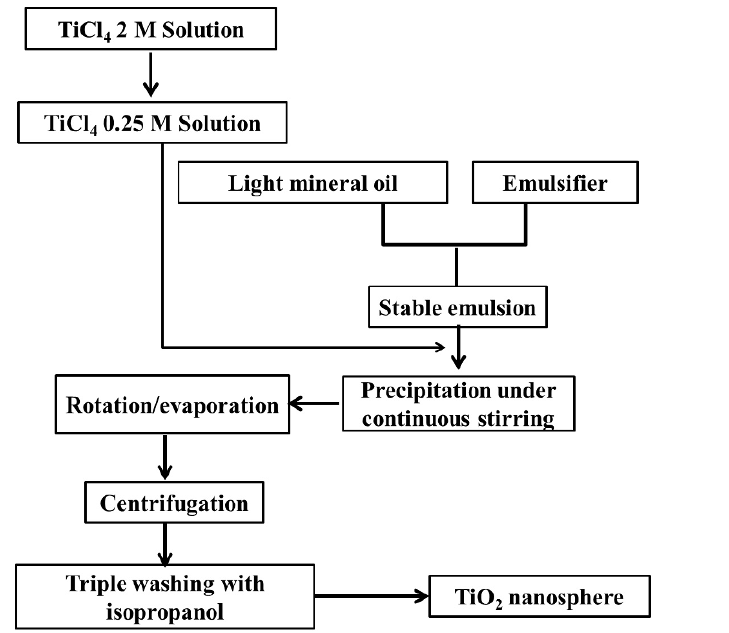
Figure 2. Scheme for the reactive microemulsion synthesis of TiO